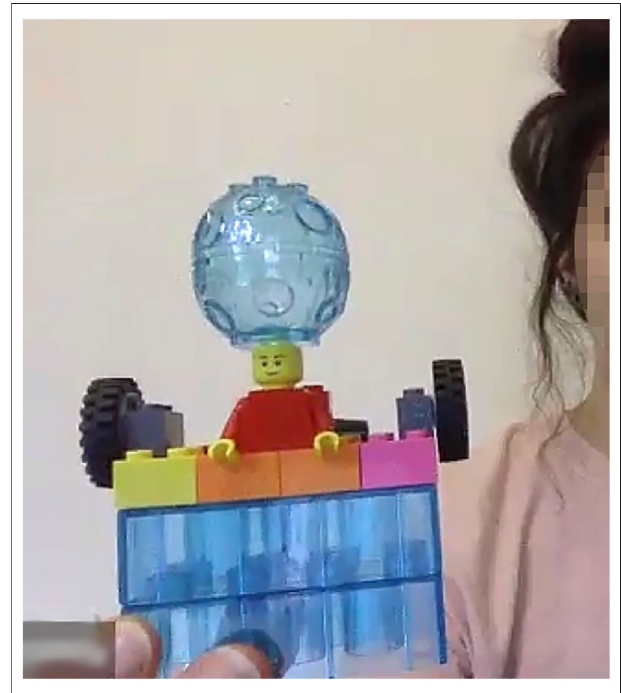
FIGURE 2 | The “ big brain ”